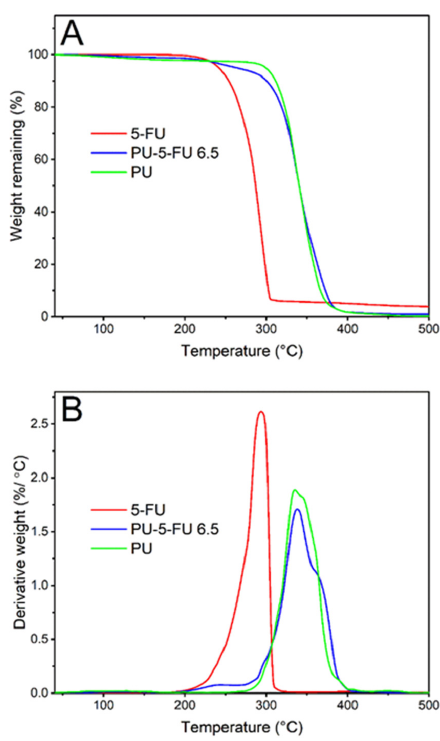
Figure 7. Thermogravimetric ( A ) thermograms recorded between 40 to 500 °C at a heating rate of 10 °C/min and ( B ) derivative weight curves for pure 5FU, and PU and PU 5FU